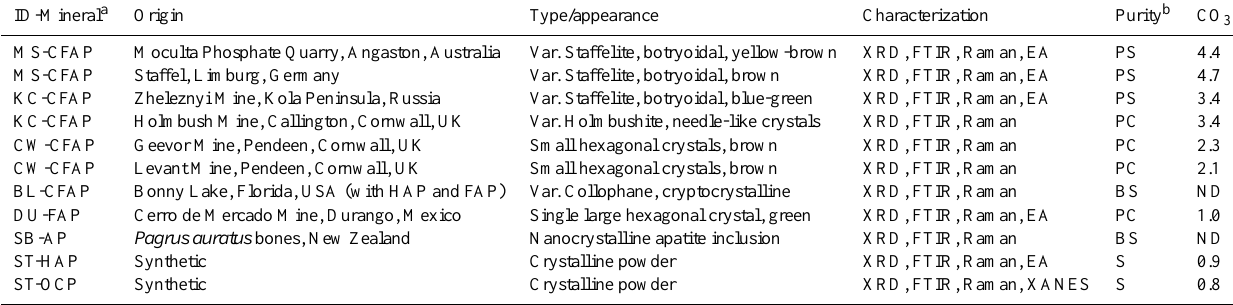
Table 1. Basic properties, performed analyses and carbonate content (% by weight) of Ca-P reference minerals used for standard addition